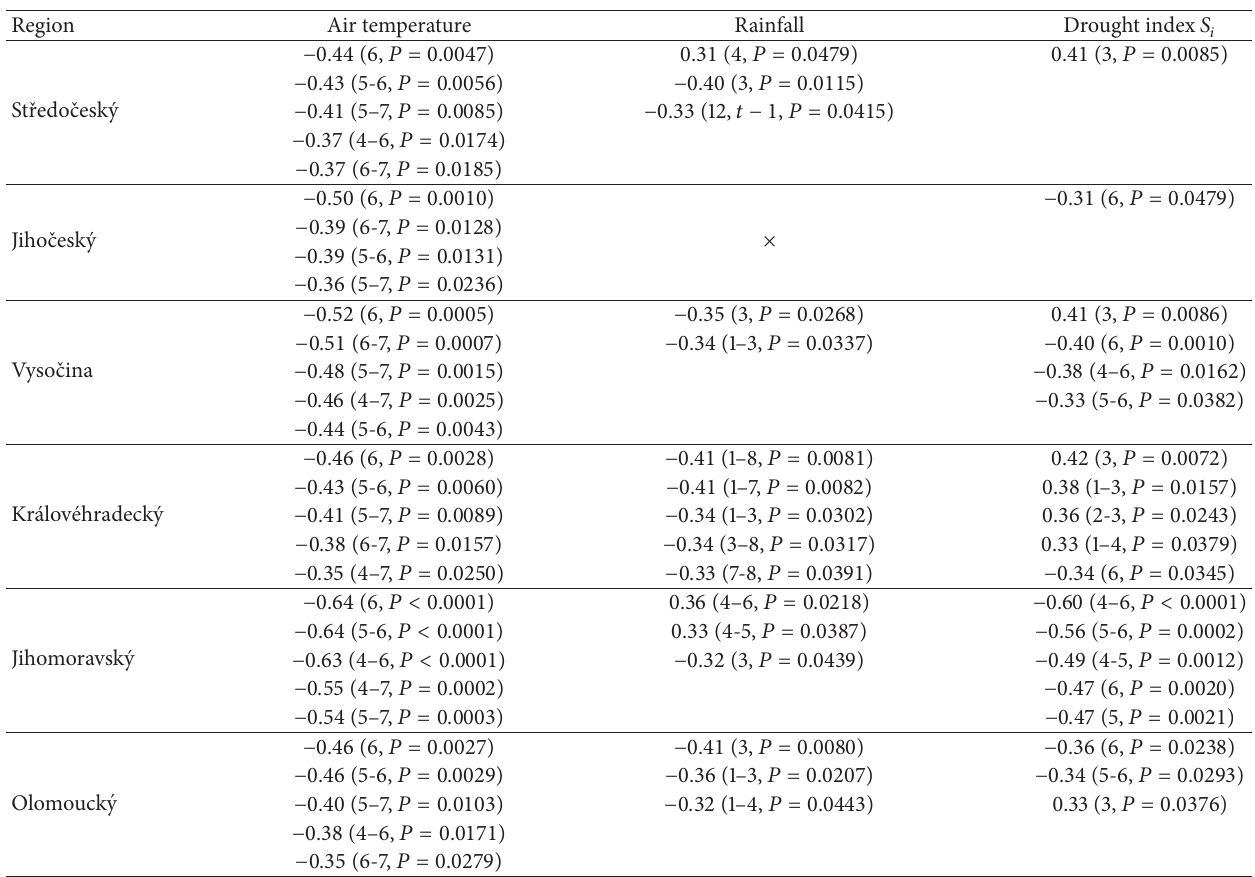
Table 7: The most significant correlation coefficients between barley yield per hectare and the average characteristics of weather in regions of the CR